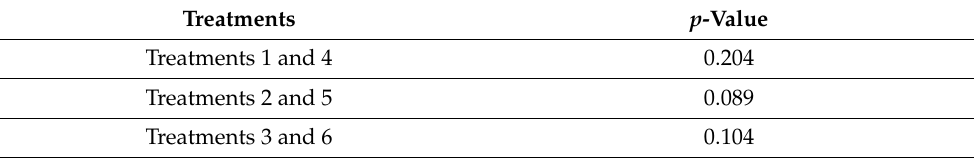
Table 3. T-test on each treatment with the same isolate across all